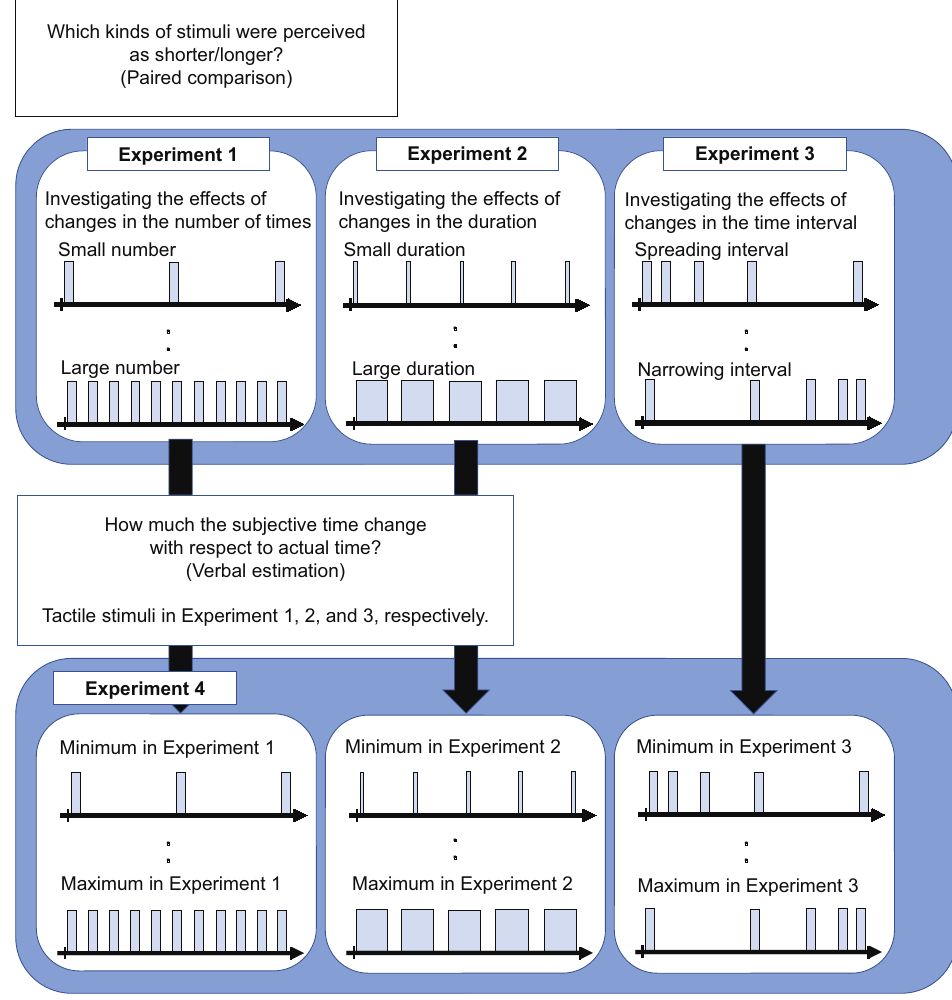
Figure 1. Overview of our